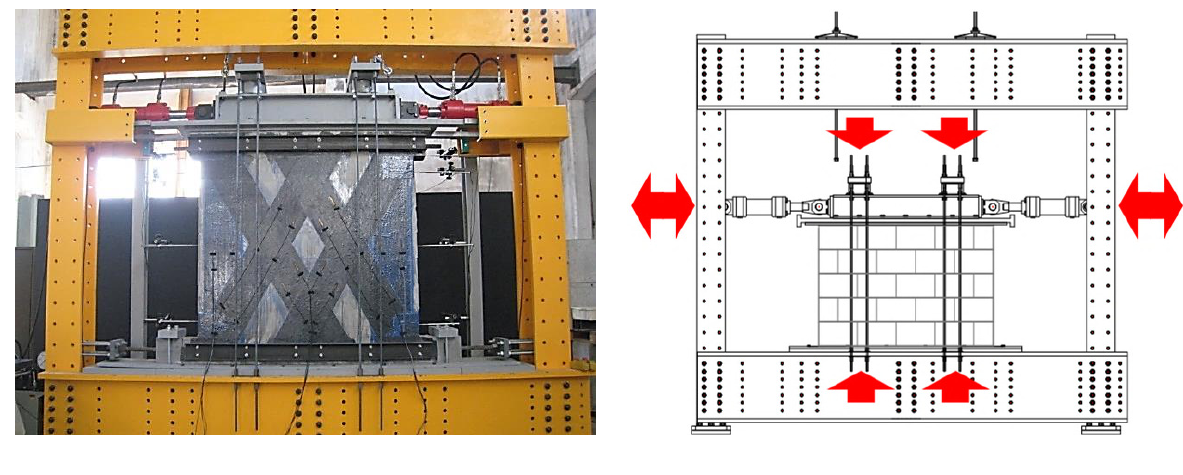
Figure 4. Set-up for static-cyclic load tests.